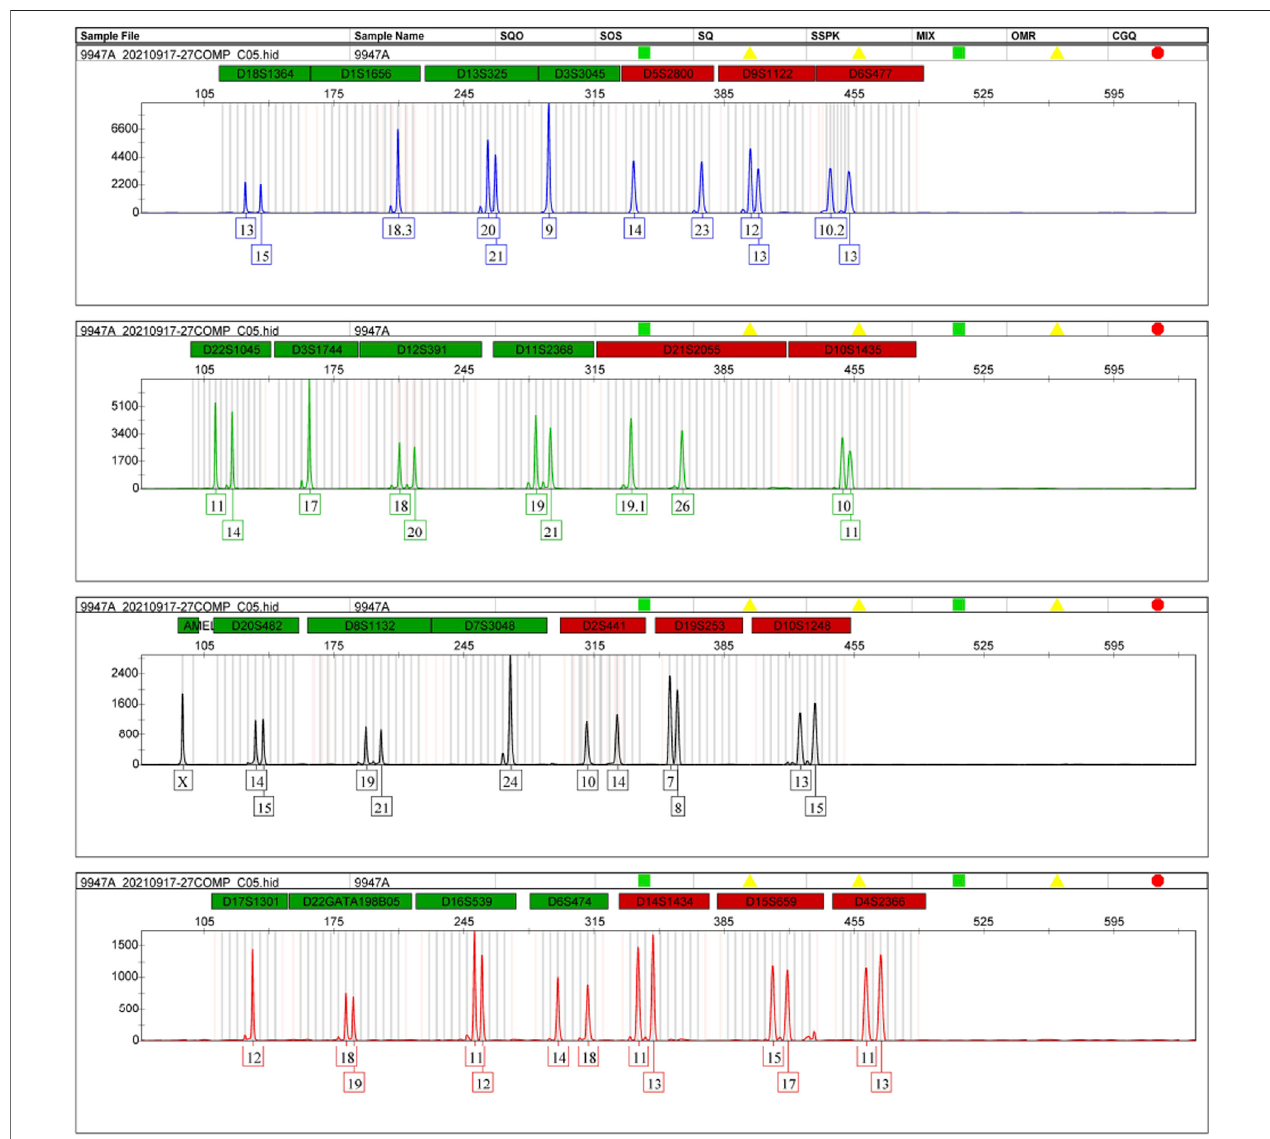
FIGURE 2 | Allelic pro fi le of the positive sample 9947A by the STRtyper-27 comp kit.